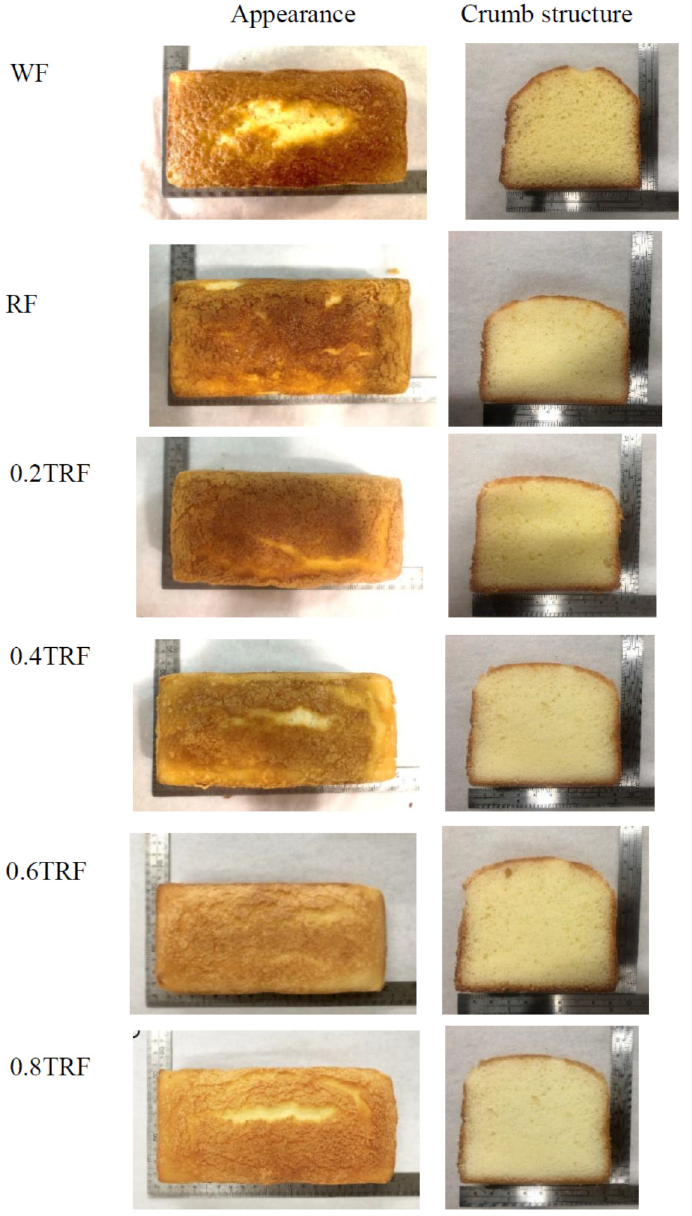
Figure 2. Appearance of cake and gluten-free cake. WF: cake made with 100% wheat flour; RF: gluten-free cake made with 100% rice flour; 0.2 TRF: gluten-free cake with 0.2% tamarind seed gum addition; 0.4 TRF: gluten-free cake with 0.4% tamarind seed gum addition; 0.6 TRF: gluten-free cake with 0.6% tamarind seed gum addition; 0.8 TRF: gluten-free cake with 0.8% tamarind seed gum